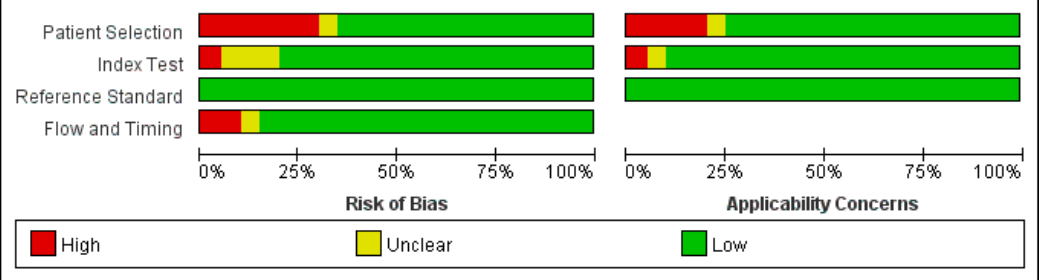
6 of 13 Figure 1. Flow diagram for selecting published studies for meta-analysis according to PRISMA guidelines, generated by Review Manager Software (RevMan version 5.3). Table 3. The data and characteristics of 14 studies whose moderate-level drug resistance breakpoint was 4–128 mg/L. Study Number Year, First Au- thor